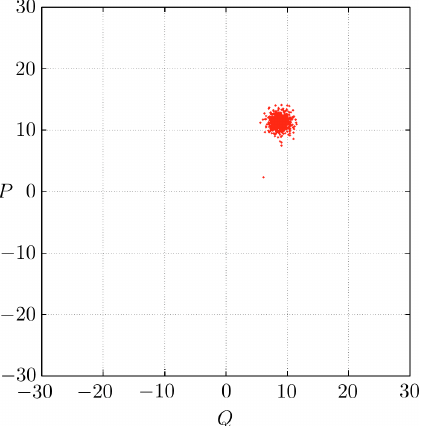
FIG. 7. The phase-space representation of signal pulses recon- structed using quadrature measurements on reference pulses and phase difference